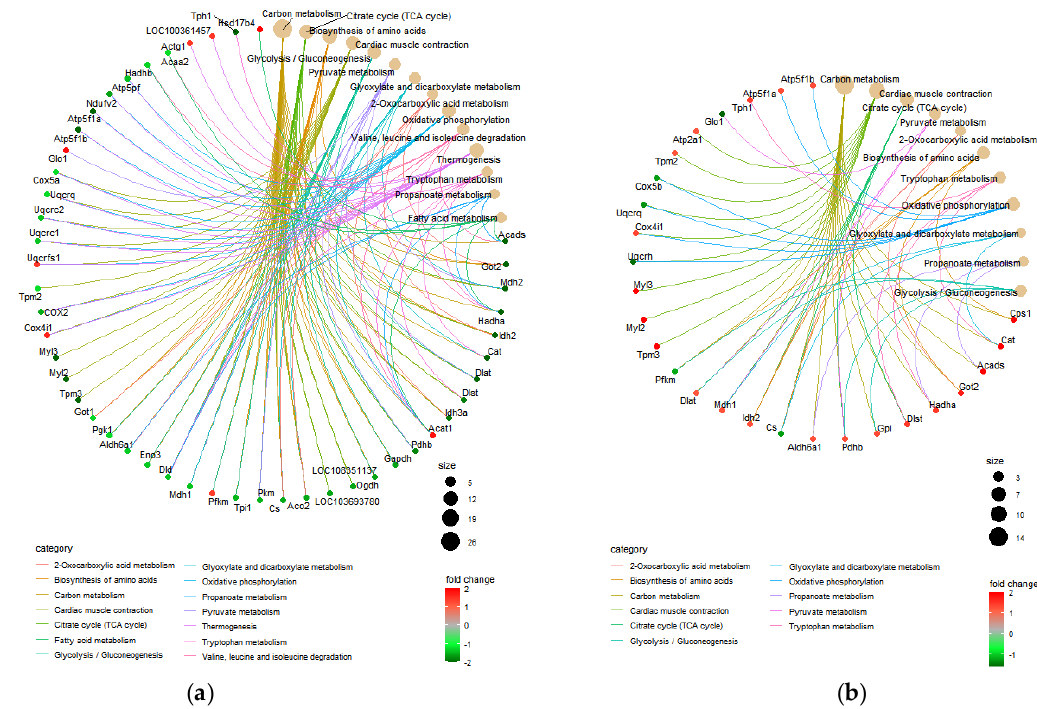
Figure 4. Chord diagram of the most relevant KEGG pathways and involved DEPs in ( a ) the RA/CON comparison and ( b ) the COR/RA